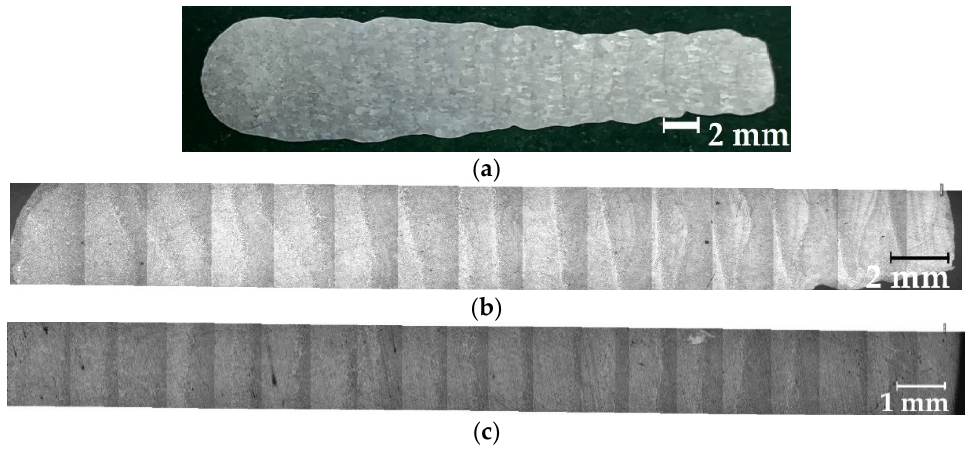
Figure 19. Optical macrostructure of the specimen with AlMg5Mn1Ti wire in WAAM: ( a ) cross- section of the specimen during deposition in pure argon; ( b ) cross-section of the specimen during deposition in the mixture of Ar + 1.6 wt.% SF 6 ; and ( c ) part of the longitudinal section of the specimen during deposition in the mixture of Ar + 1.6 wt.% SF 6 .